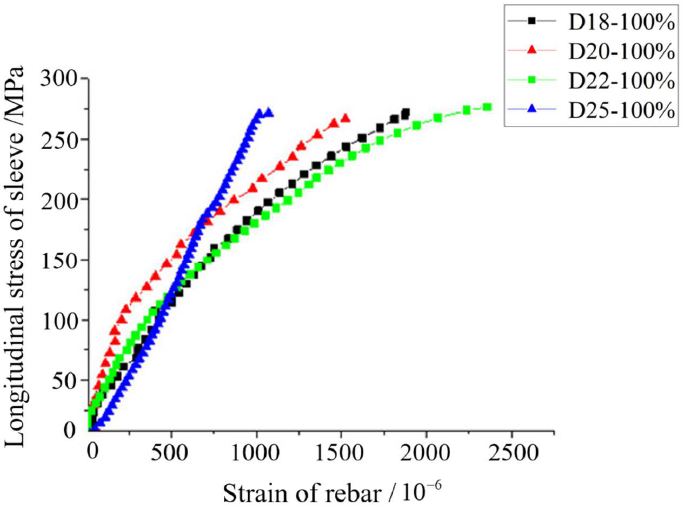
Figure 12. Longitudinal stress-strain curves of sleeve for fully compact connectors. The stress-strain curves of sleeves for D 18 connectors with different compactness are shown in Figure 13. The observed phenomenon and laws are similar to those of rebar for the connectors with different compactness (as shown in Figure 11). The sleeves of GSS connectors have much lower tensile stresses and tensile strains. The maximal tensile stresses and tensile strains are less than 100 MPa for sleeves with lower compactness (D18- 70%, D18-50%), which means the sleeves are still in the elastic stage. The curves drop ab- ruptly in their rise due to either the snap of the rebar or the bond-slip of the rebar-grout. It is noteworthy that the longitudinal stress-strain curves of D 18-90% sleeves in Figure 13 show abnormality. One possible reason for this is that a closure of cracks in the grouting material has occurred at loading and it has a greater effect than the newly developed cracks in the grouting material.